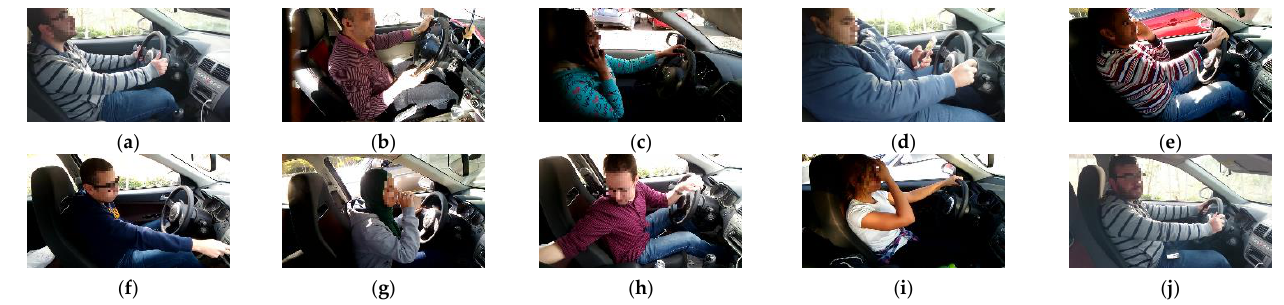
Figure 6. Some sample pictures from the AUC2D dataset. ( a ) Safe driving ( b ), texting-right ( c ), talking on the phone-right ( d ), texting-left ( e ), talking on the phone-left ( f ), operating the radio ( g ), drinking ( h ), reaching behind ( i ), hair and makeup ( j ), talking to passenger.